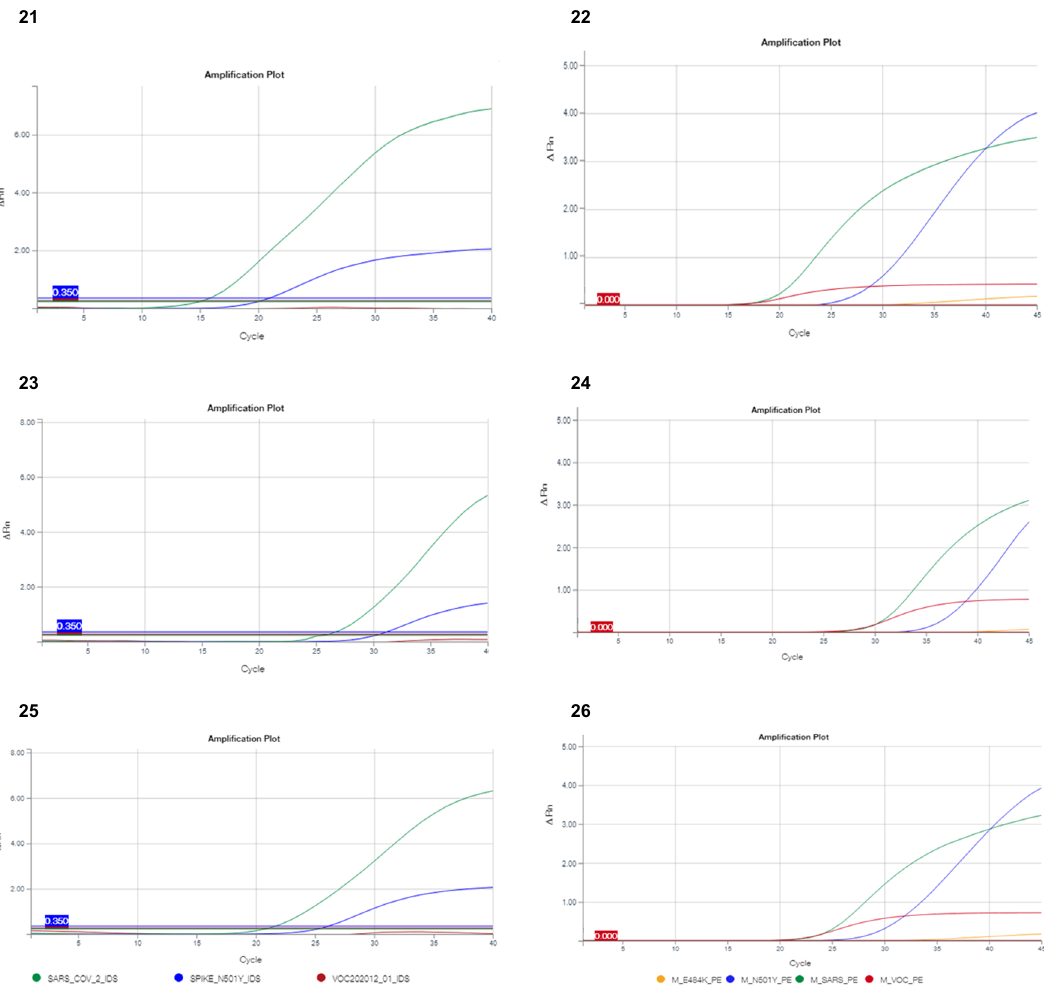
Figure 1. Representation of different variant profiles with the screening RT-PCR assays (on the left the results obtained with the ID Solution kit, and on the right those with PerkinElmer kit). All interpretations of described profiles were derived from NGS analysis. With the ID Solution kit, the green, blue and red curves correspond to SARS-CoV-2, N501Y and ΔH69/ΔV70, respectively. With the PerkinElmer kit, the green, blue, red and orange curves correspond to SARS-CoV-2, N501Y, ΔH69/ΔV7 and E484K, respectively. ( A , D ) profile of B.1.1.7 UK variant; ( B , E ) profile of B.1.1.7 variant with S71F mutation; ( C , F ) profile of P.1.351 or P.1 variants. * with or without S67A mutation, ( D , E ) were B.1.1.7 without E484K mutation. ( G ) detailed profiles of the 13 samples: 1 and 2: hCoV-19/France/OCC-NI-2104021309/2021; 3 and 4: hCoV-